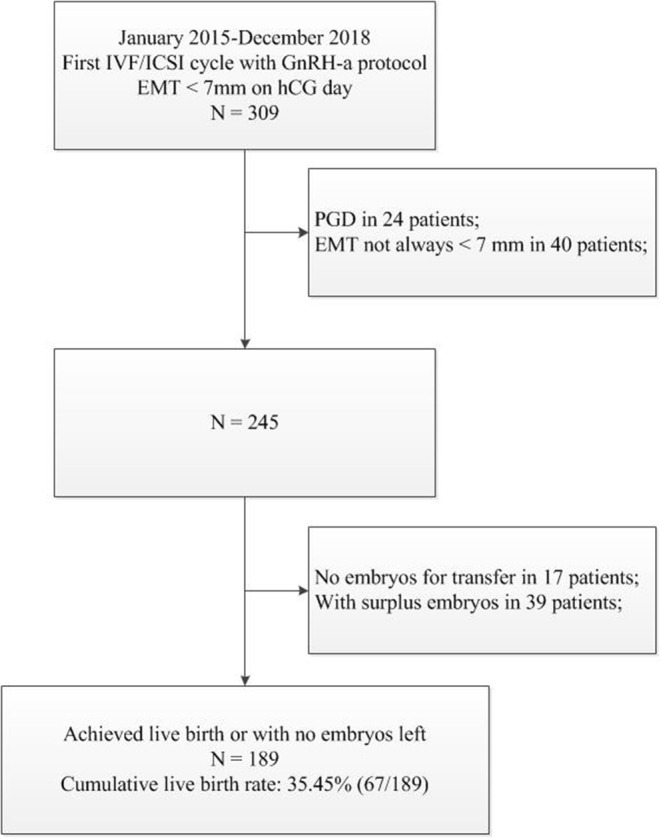
Study Flow Chart.